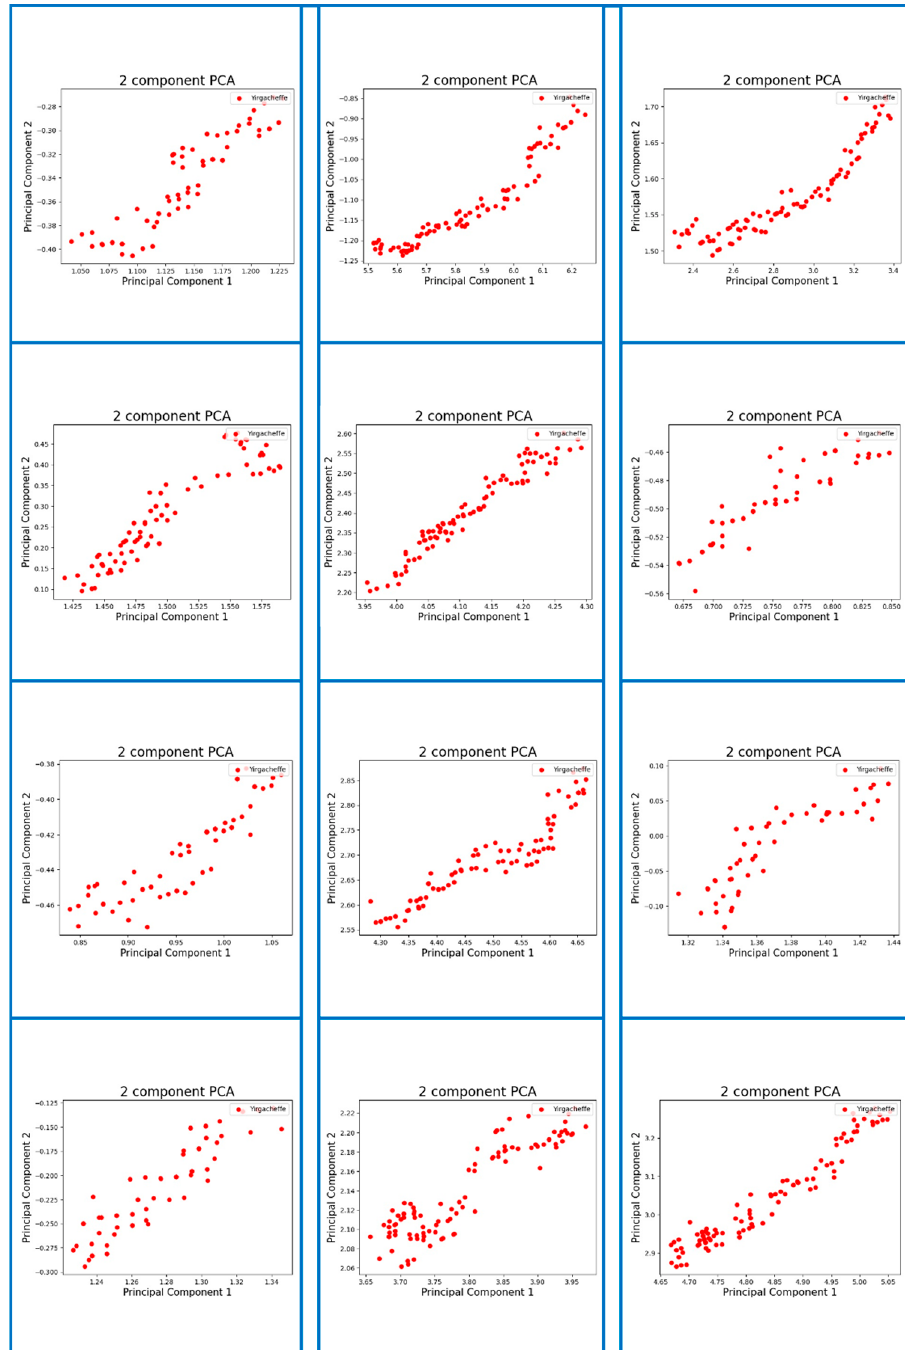
Figure 7. Sample digital fingerprints of coffee aromas originating from Yirgacheffe, Ethiopia.